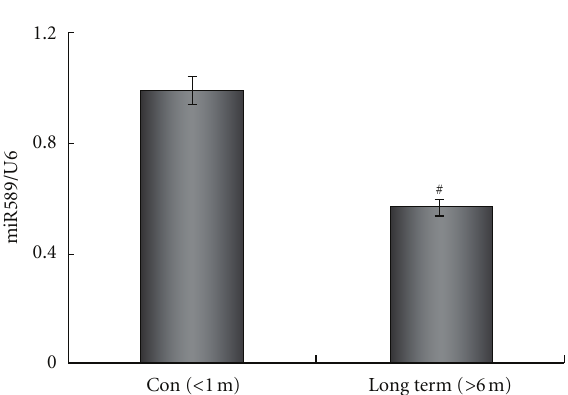
Figure 1: Expression of miRNA589 in HPMCs isolated from CAPD patients e ffl uents, as assessed by realtime PCR. The bar graphs represent the 2 − ΔΔ C T value of miRNA589 relative to U6 ( # P < 0.05 versus the control patients). The data are presented as the mean ratio ± SD, respectively. The ratio of miRNA in long term CAPD group was 0.5765 ± 0.0546. # versus control group, P < 0.01.